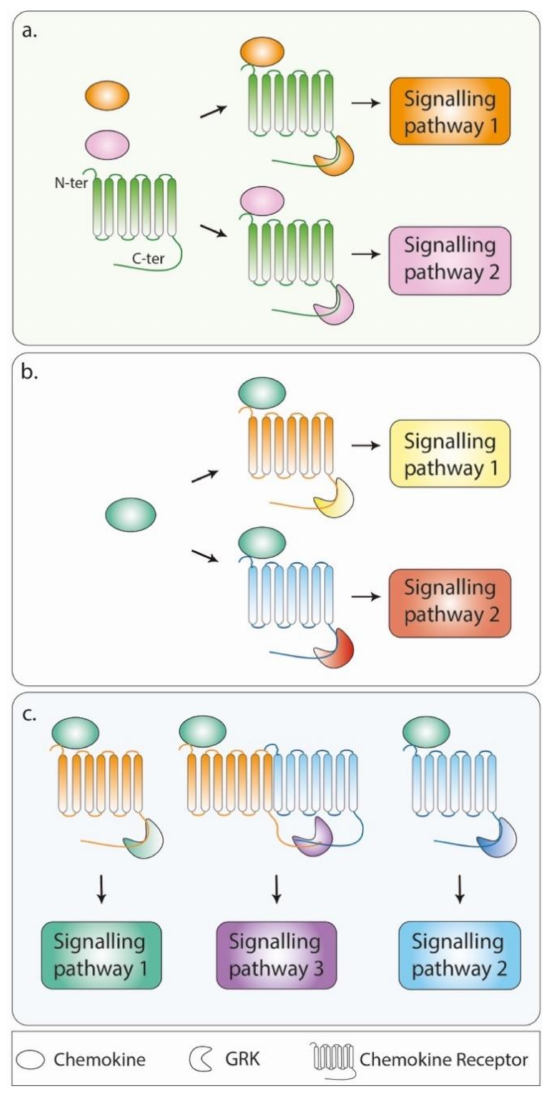
Figure 1. Chemokines and their receptors bias the G protein-coupled receptor kinase (GRK)- associated phosphorylation barcode. According to this bias, receptors adopt different conformational states that mask or unmask specific serine or threonine sites for GRK-dependent phosphorylation. ( a ) Different ligands may bind the same chemokine receptor, promoting the differential recruitment of GRKs that activate distinct signalling pathways. An example of this situation is illustrated by